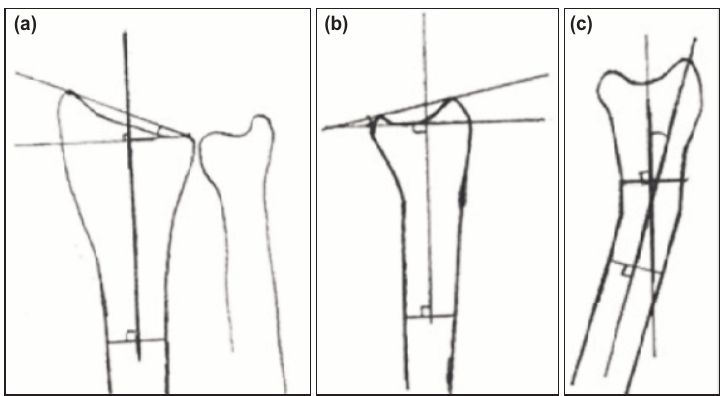
(a) An illustration showing a radial inclination which is an angle formed between a line over the plane of articular surface of Fig. 1: the distal radius and a line perpendicular to the axis of the radius on the anteroposterior radiograph, (b) a palmar or a dorsal tilt which is an angle formed between a line over plane of articular surface of distal radius and a line perpendicular to the axis of the radius on the lateral radiograph, (c) a dorsal or a palmar angulation which is an angle formed between axis of proximal and distal parts of fracture fragments.